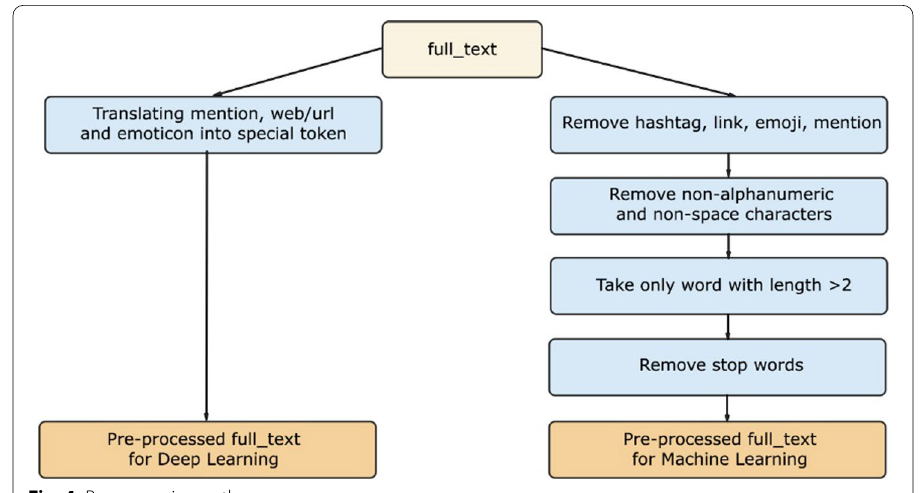
Fig. 4 Preprocessing path